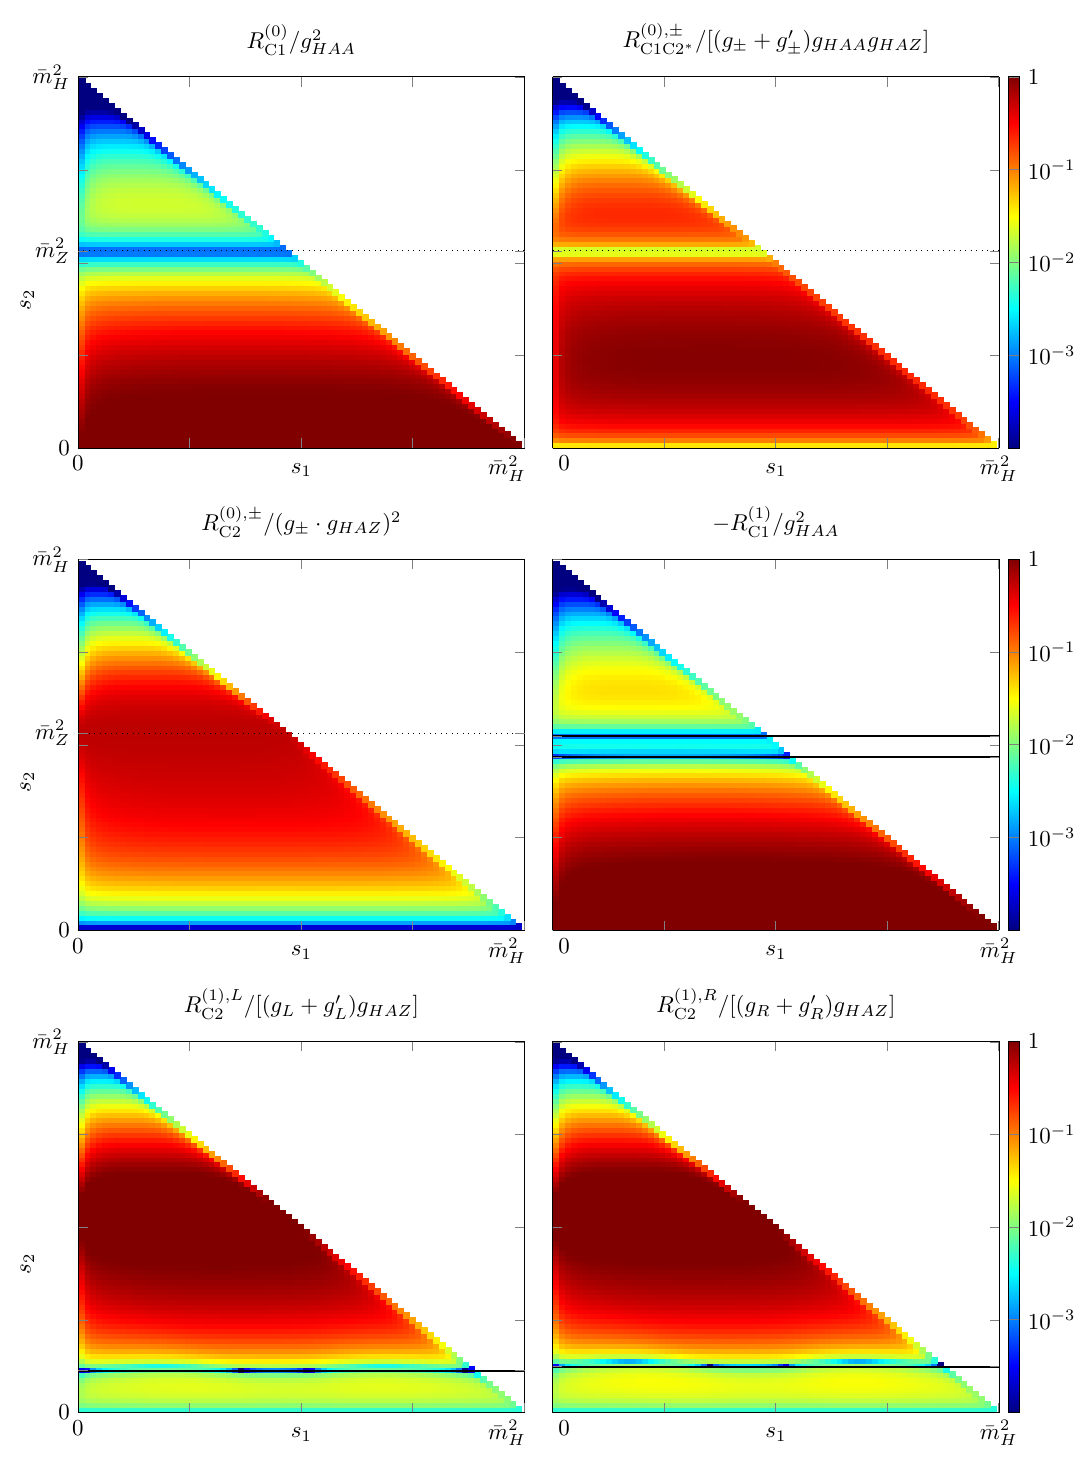
Figure 6: Dalitz-like plots showing the ratios defined in Eq. 35. Normalization is arbitrary as prefactors related to the Wilson coefficients have been pulled out of the ratios. In some cases a sign has been pulled out of the ratio as well. “ ± ” is used when both the left and right hand parts are equal up to the normalizations factored out in the plot (as indicated by the title). Solid black lines show where the ratio flips signs, the top-most region is always positive. Cuts on the angle between the photon and two leptons are not included in these Dalitz